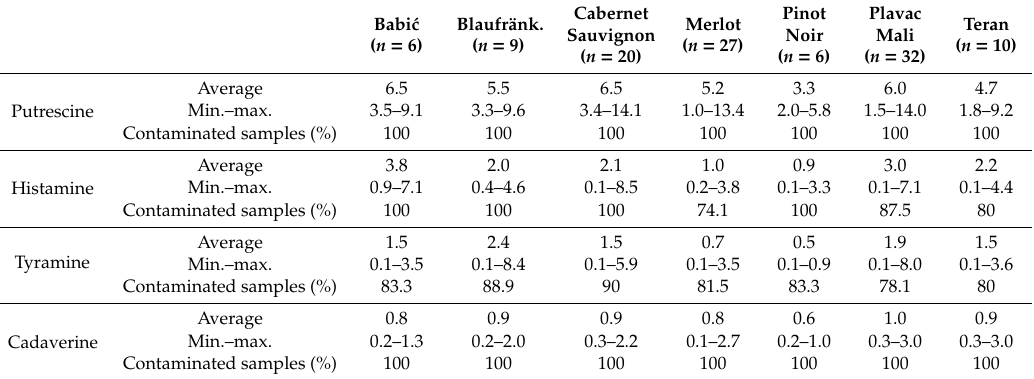
Table 6. Concentrations of biogenic amines (mg / L) according to grape